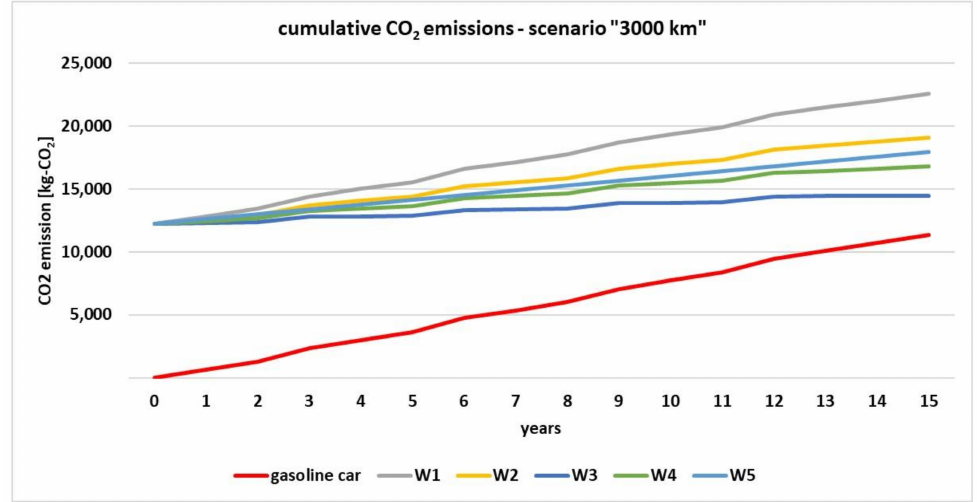
Figure 6. Comparing the cumulative CO 2 emissions for a gasoline car and an electric car in each year of operation (3000 km/year